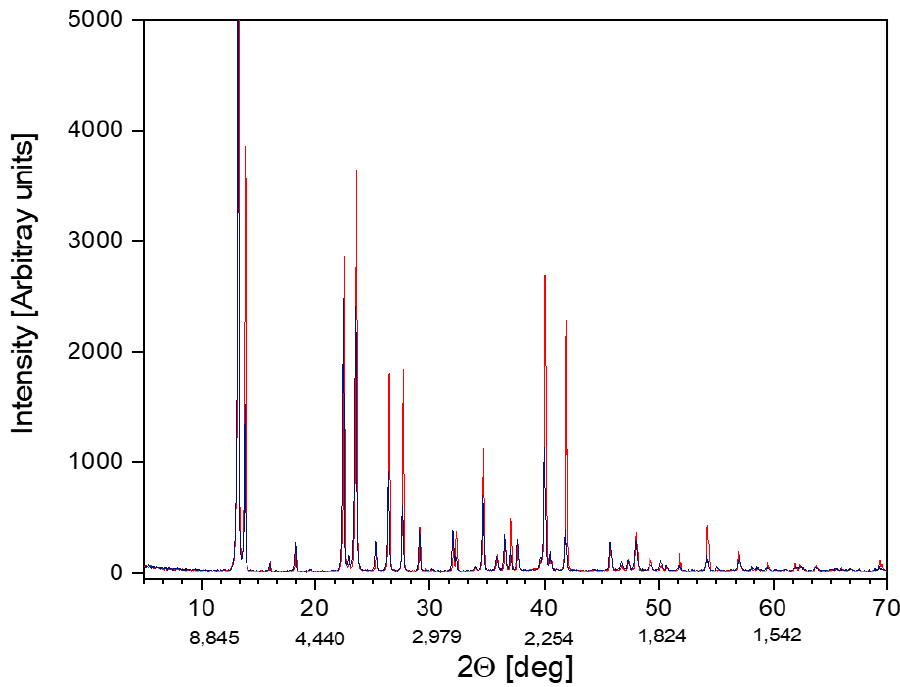
Figure 1. Comparison of the XRD curves of the reaction products prepared with the methods of Mitscherlich [15] (blue) and Scagliari [11] (red).